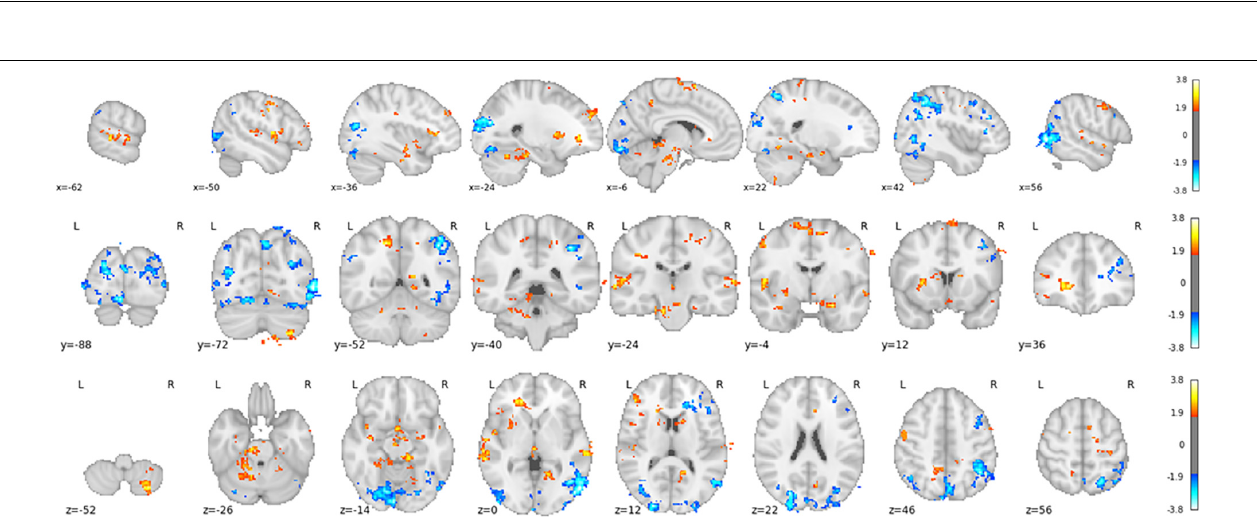
FIGURE 4 | T-value map of classifier weights, computed using a one-sample t -test against 0, thresholded at t > 1.7 and only showing clusters with more than 200 voxels. Clusters in yellow/red and blue are associated with imagery and attention predictions, respectively.